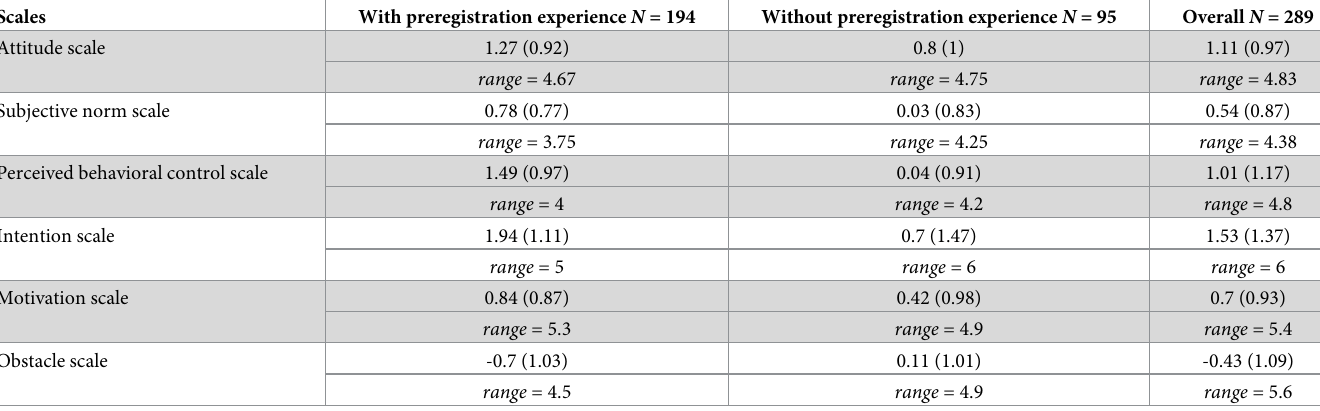
Table 3. Overview of scales used for the hypotheses